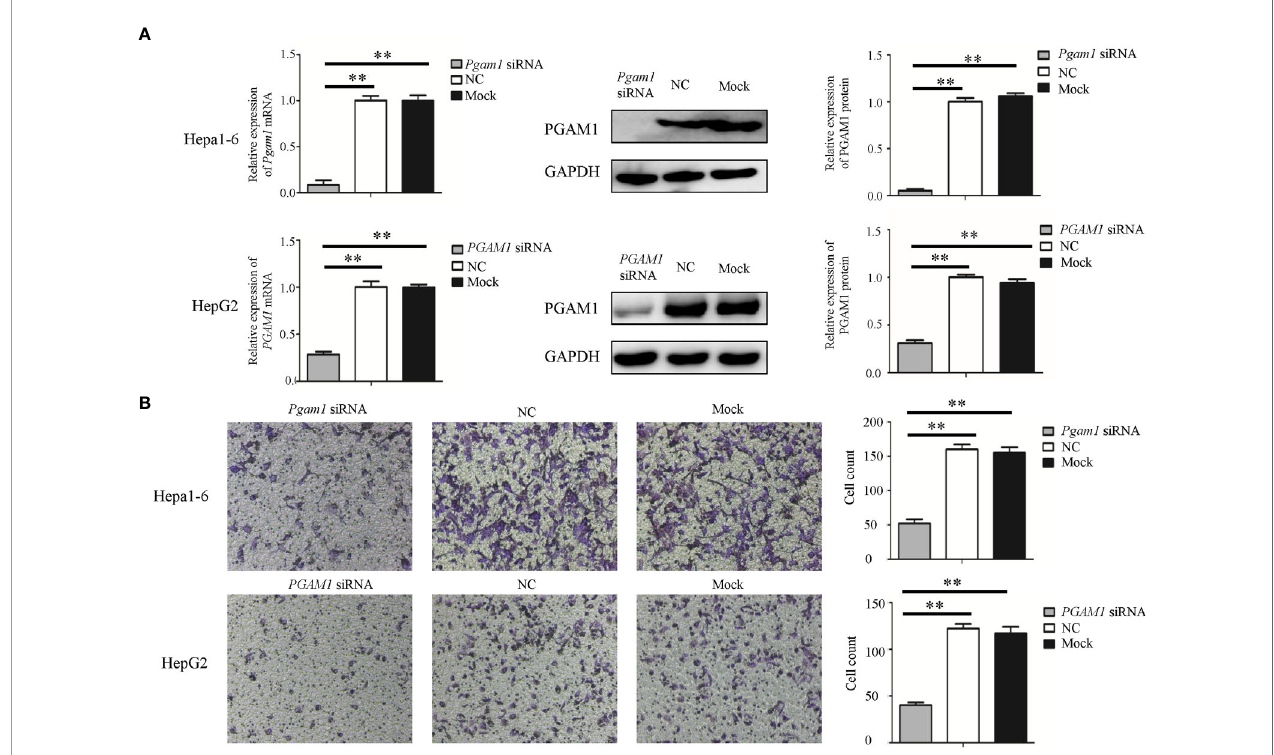
FIGURE 4 | Knockdown of PGAM1 inhibits cell migration of hepa1-6 and HepG2 cells in vitro. (A, B) Hepa1-6 and HepG2 cells were transfected with PGAM1 siRNA and negative control (NC) siRNA, respectively, and 48 h later, the expression of PGAM1 was determined using qRT-PCR and Western blotting (A) . Cell migration was evaluated using transwell inserts without matrigel coating (B) . Data are presented as the mean ± SD, n = 3, ** p <